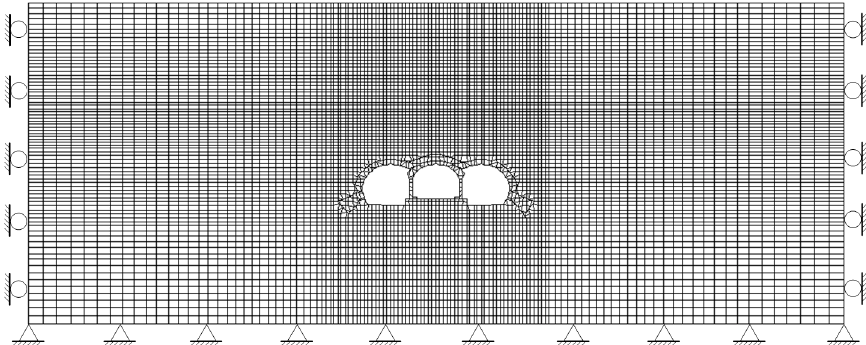
Figure 6. Two-dimensional model showing the finite mesh and boundary conditions for the analysis.